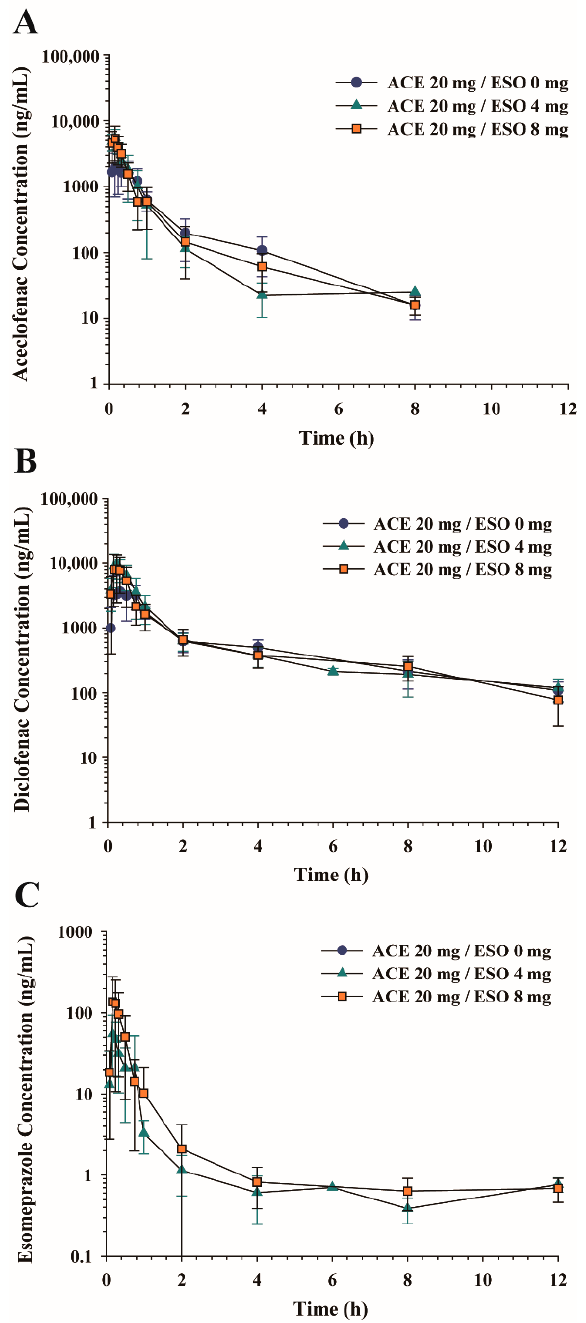
Figure 2. Average plasma concentration-time profiles of ( A ) aceclofenac, ( B ) diclofenac, and ( C ) esomeprazole following oral administration of aceclofenac (20 mg/kg) in combination with esomeprazole (0, 4, 8 mg/kg) in rats. Data represent mean ± SD ( n =